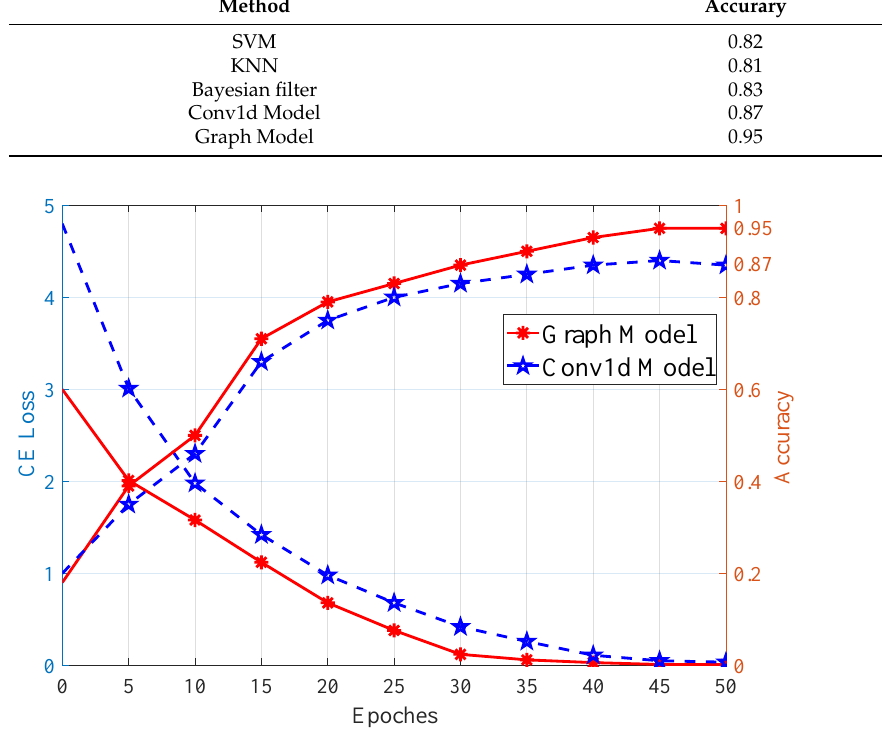
Figure 9. This figure shows the testing results of the GCN and Conv1d modal, with the left axis representing the training loss and the right axis showing the recognition accuracy. As seen from the figure, the train loss of the GCN modal decreases sharply in the first 25 epochs, and slowly in the last 10 epochs until the loss value reaches 0.0095 after 40 epochs. The train loss of the Conv1d model decreases sharply in the first 10 epochs, and the loss reaches 0.0518 after 45 epochs. From the comparison, it can be concluded that the GCN model has three advantages: (1) the initial loss is lower, (2) the model converges more quickly, (3) the total loss is